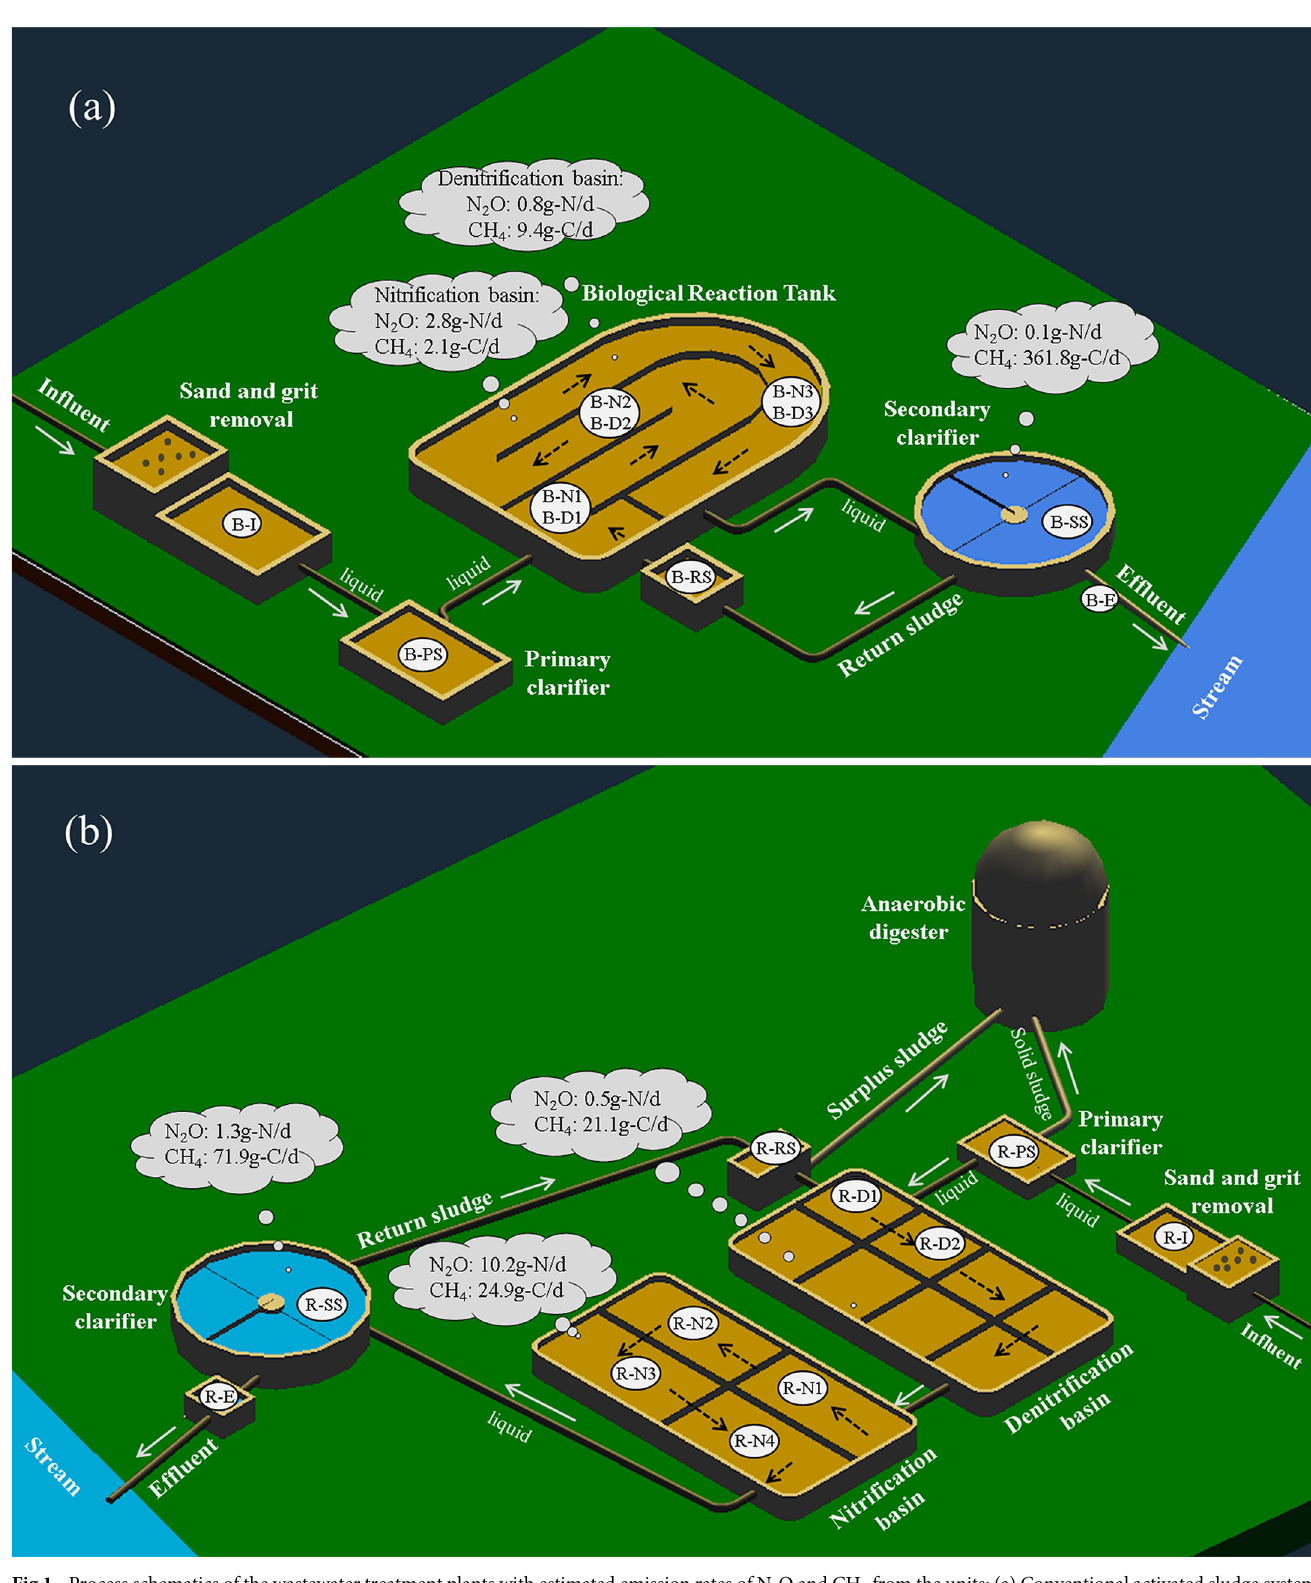
Fig 1. Process schematics of the wastewater treatment plants with estimated emission rates of N 2 O and CH 4 from the units: (a) Conventional activated sludge system at Bellheim, (b) Modified Ludzack-Ettinger system with anaerobic digestion at Ruelzheim. Sampling stations are shown as ID in the light-gray circle. https://doi.org/10.1371/journal.pone.0209763.g001 PLOS ONE | https://doi.org/10.1371/journal.pone.0209763 January 4,